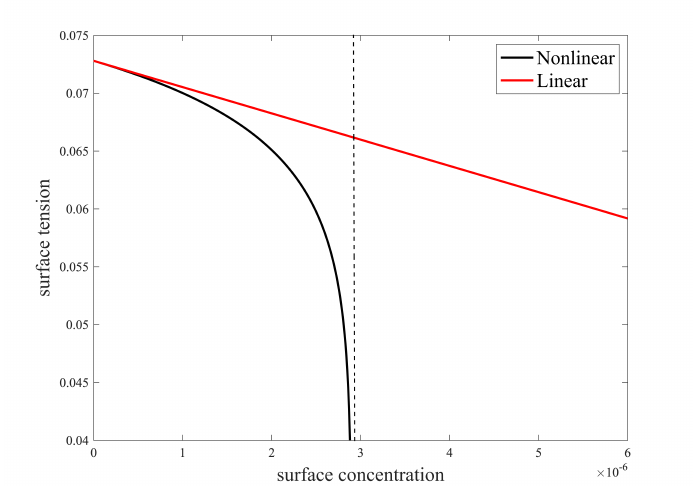
Figure 2. Dependence of the surface tension coefficient σ on the interface concentration f expressed by the Langmuir state equation. The dotted line indicates the saturation